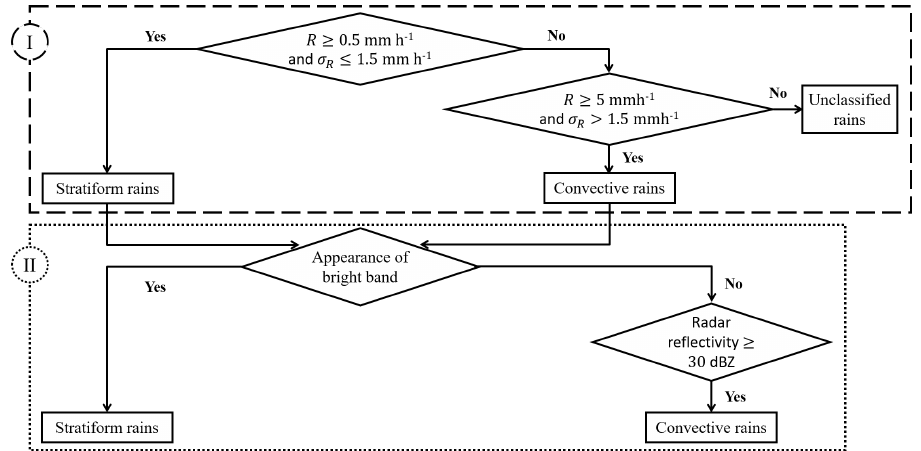
Figure 2. Flowchart for the identification of rainfall types through the BR03 (I) and VPR (II) methods, with the dashed ( ) and dotted ( ) boxes, respectively. The unified method BR03-VPR, is a combination of the boxes I and